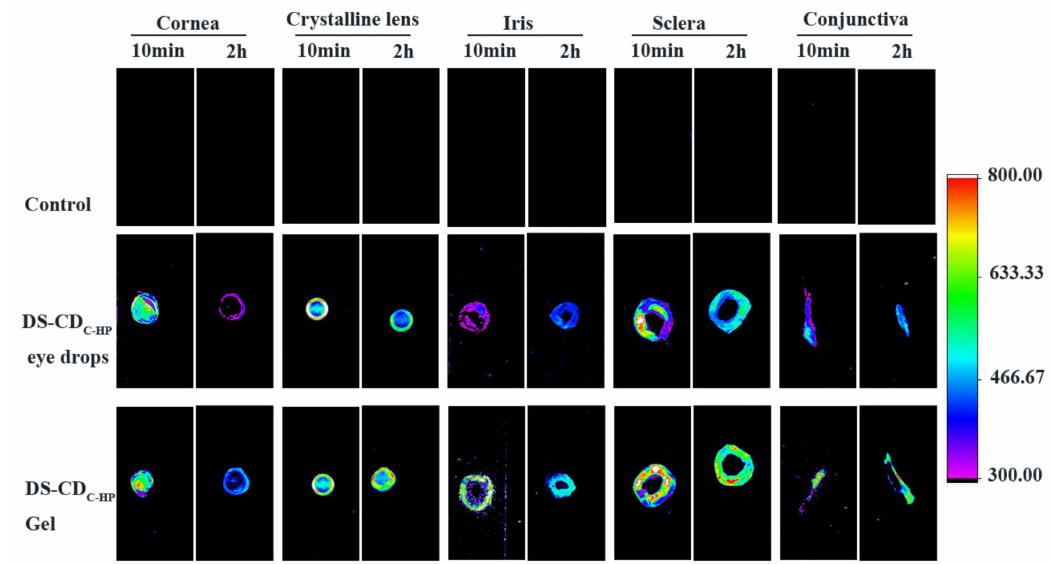
Figure 6. Fluorescence images of ex-vivo ocular tissues from DS-CD C-HP eye drops and DS-CD C-HP -Gel treated rabbit eyes at 10 min and 2 h.